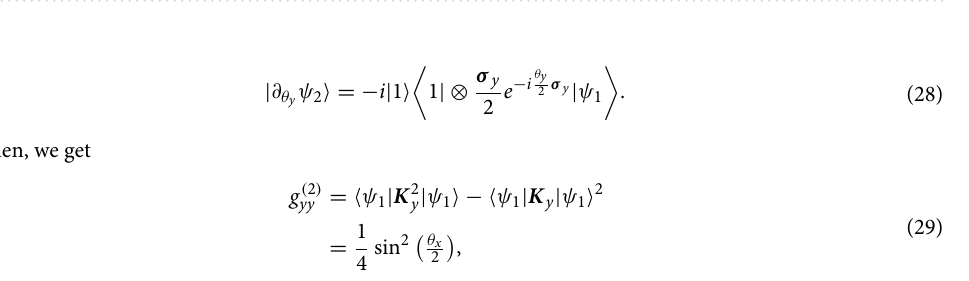
Figure 6. Plot of fidelity as a function of L for different W structures and different optimizers. ( a ) ( W chain , SGD), ( b ) ( W chain , Adam), ( c ) ( W chain , QNG), ( d ) ( W alternating , SGD), ( e ) ( W alternating , Adam), ( f ) ( W all_to_all , QNG), ( g ) ( W all_to_all , SGD), ( h ) ( W all_to_all , Adam), ( i ) ( W all_to_all ,